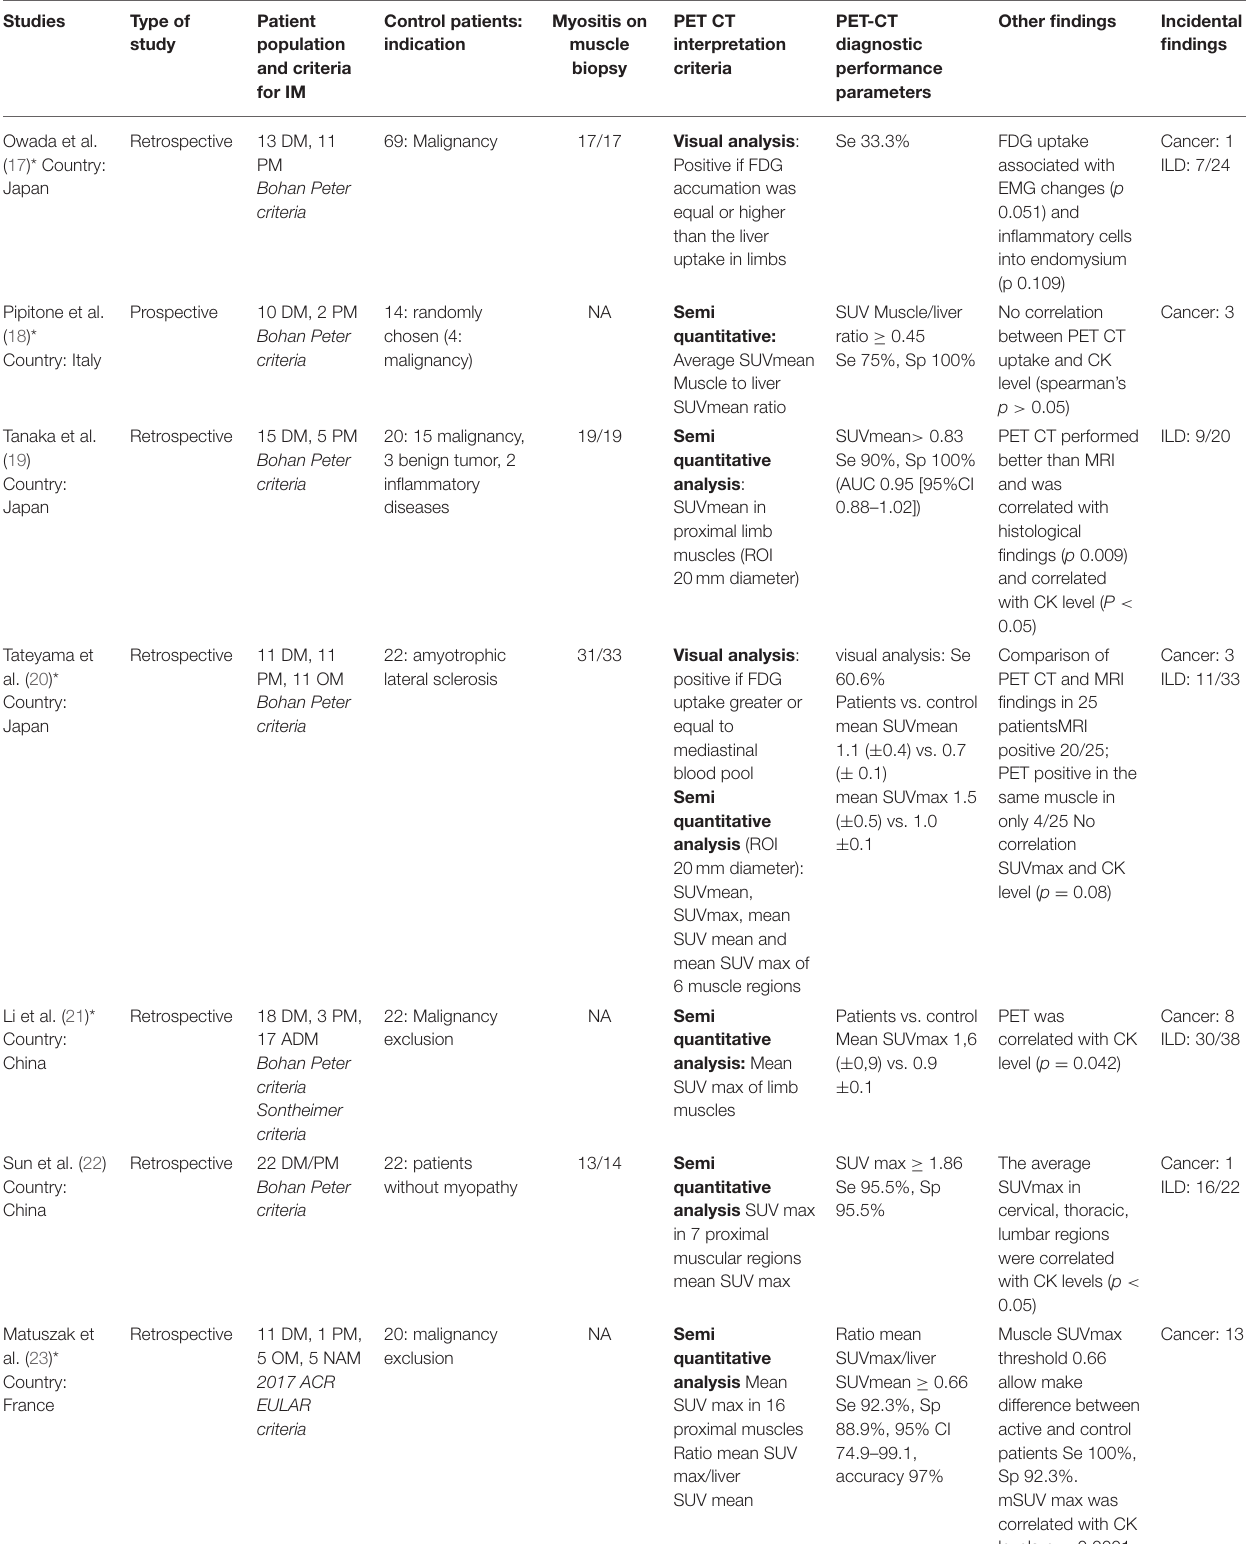
TABLE 1 | Studies evaluating the performance of [ 18 F]FDG-PET/CT in inflammatory